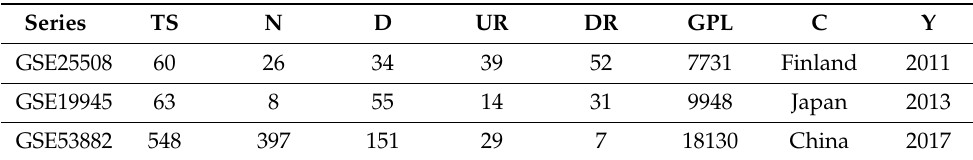
Table 1. List of datasets used in the network